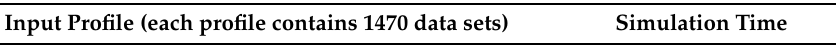
Table 4. Simulation time of the finite volume-based evaporator model.